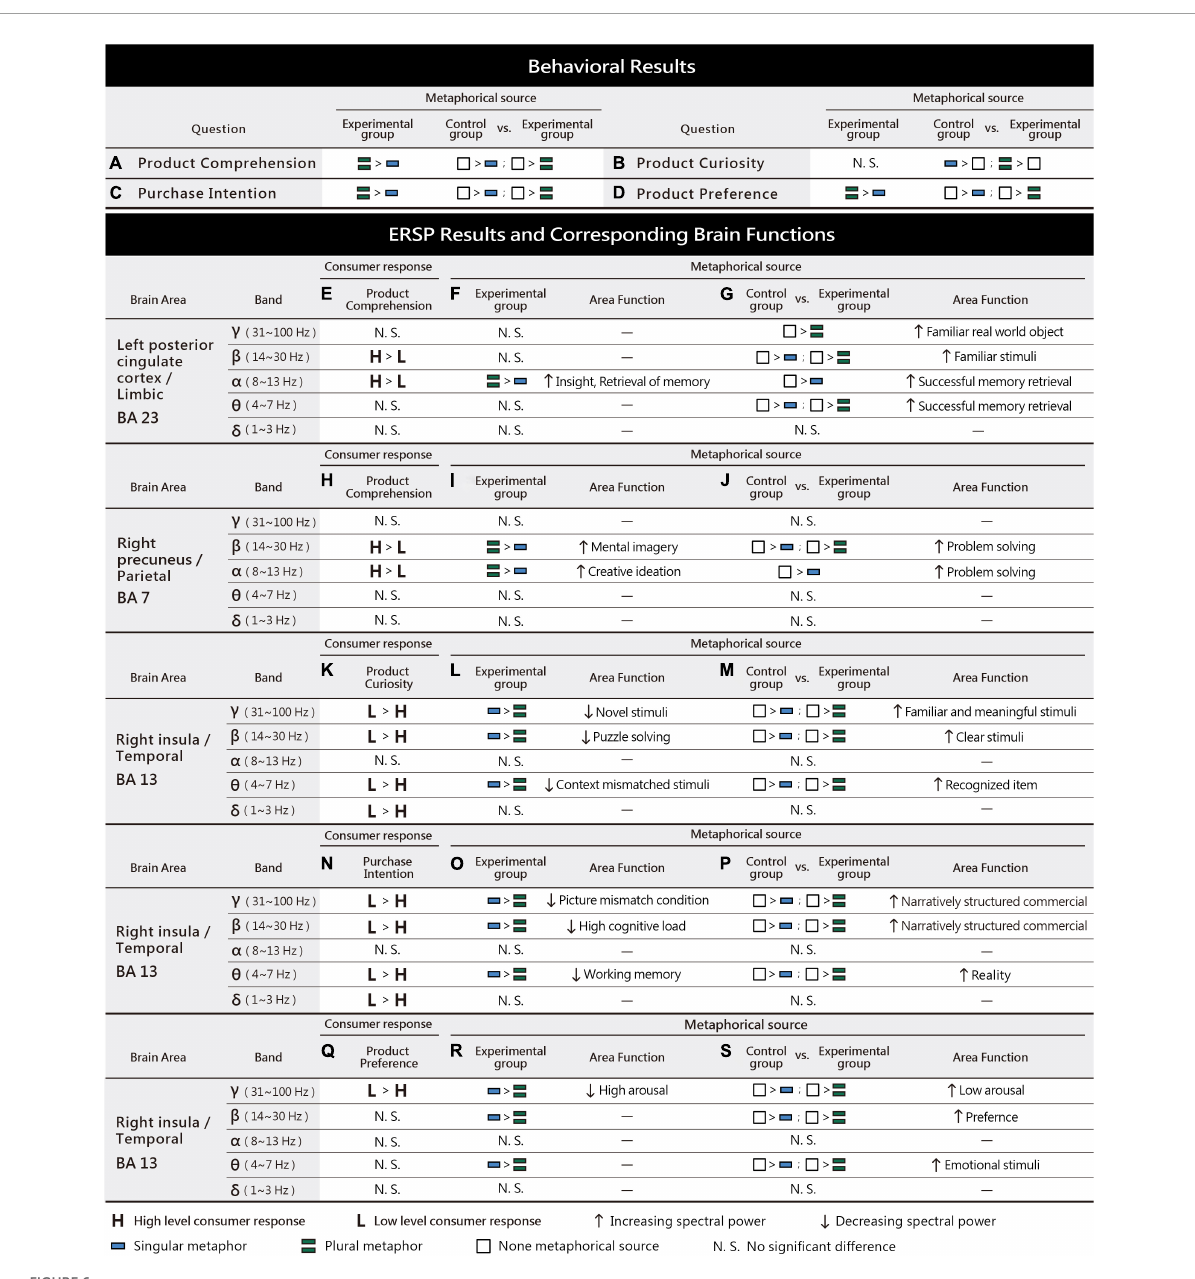
FIGURE6 (A–D) Behavioral results showing the effects of different numbers of metaphorical sources on product comprehension, curiosity, intention, and preference. (E–S) ERSP results of high/low-level consumer responses, different metaphorical sources, and corresponding brain functions.